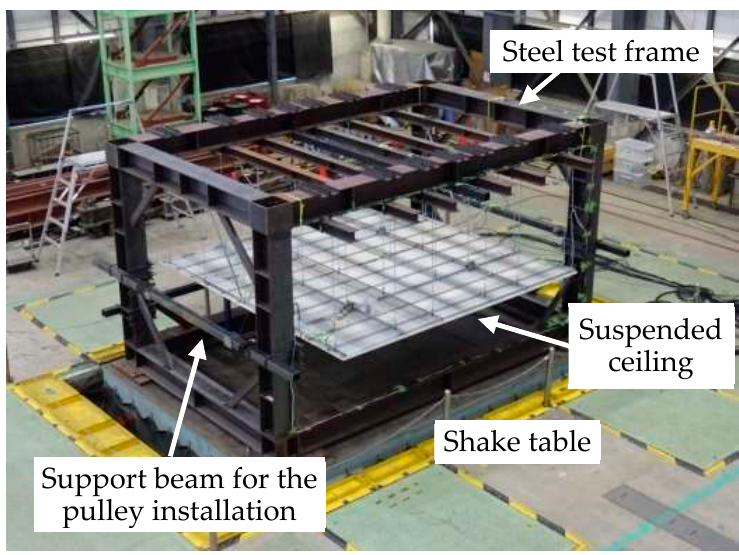
Figure 11. Overall view of the SCS specimen on the shake table.